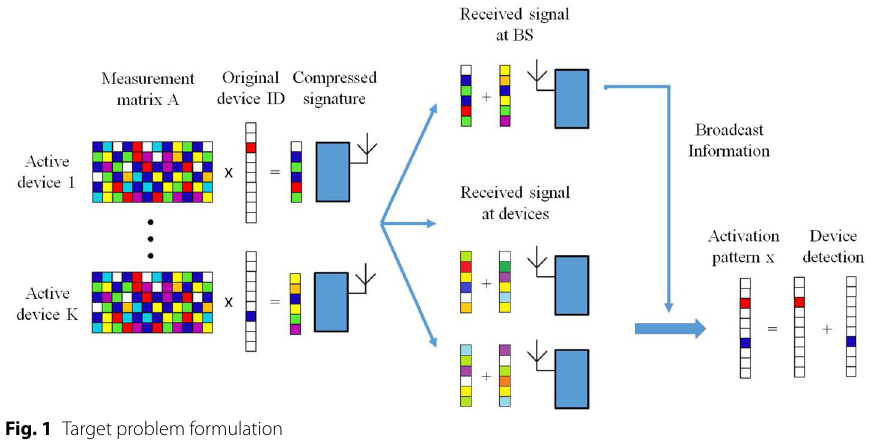
Fig. 1 Target problem